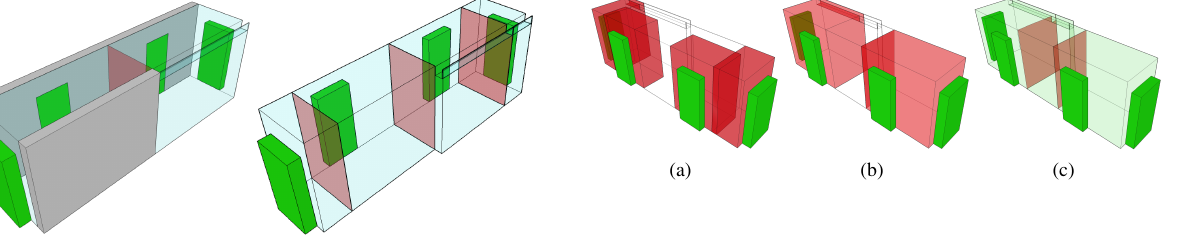
Figure 7. Subdivision based on geometric, topological and semantic criteria. (a) Result similar to the subdivision in Fig. 5. (b) Special sub-spacing criteria at door-corridor relations. (c) Merging of intersecting subspaces. (d) Final subdivision of the Figure 6. Subdivision mainly based on topological criteria. (a) corridor. Sub-spacing considering the relations to the walls (result similar to the subdivision in Fig. 5). (b) Sub-spacing considering the relations to the doors.